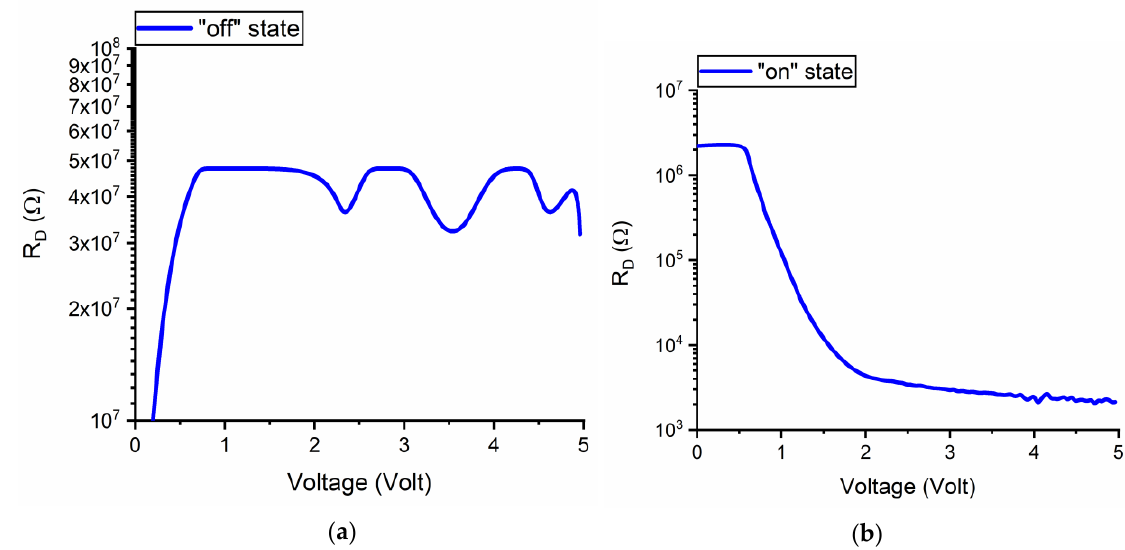
Figure 8. Equivalent circuit of the FTJ-based microwave switch when ( a ) the FTJ is in its reverse polarization state (a negative DC polarity is applied) and ( b ) the FTJ is in its forward polarization state (a positive DC polarity is applied).